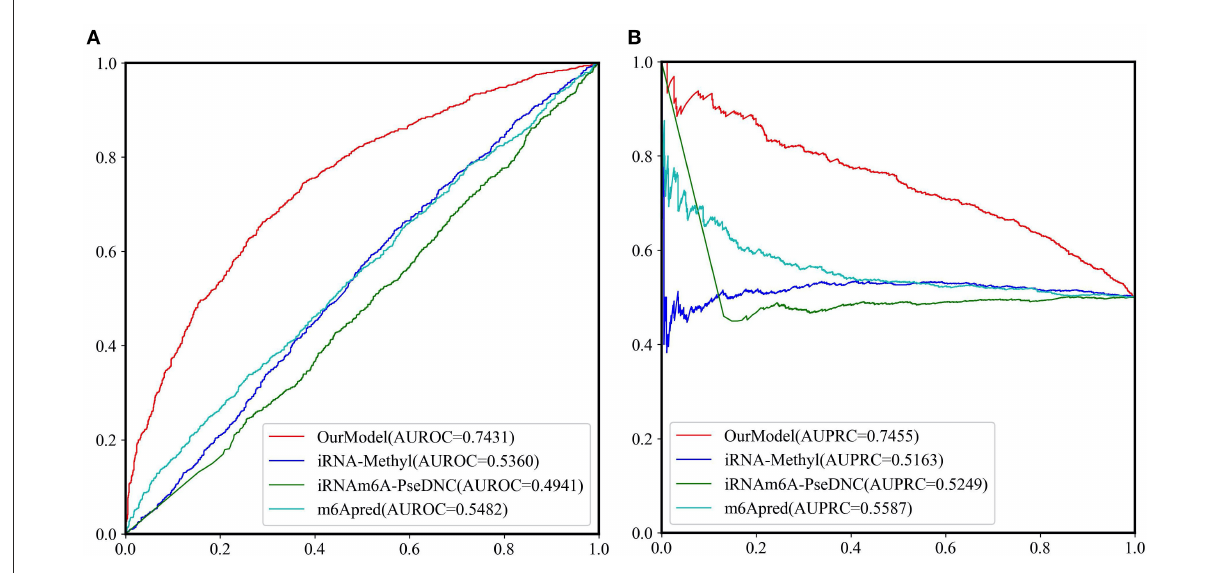
FIGURE6 The ROC curves and PRC curves based on the predictive results of the independent test set GAC_2344 by our model and the other three methods. (A) ROC curves; (B) PRC curves.